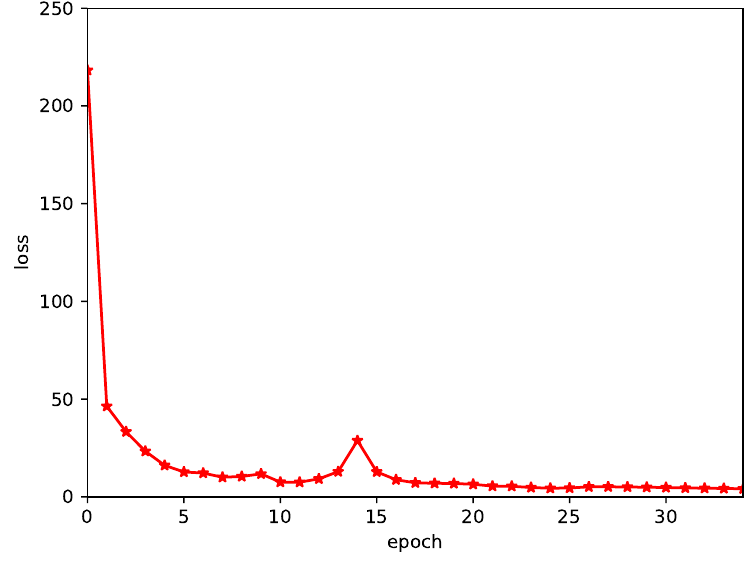
Figure 6. Pre-training